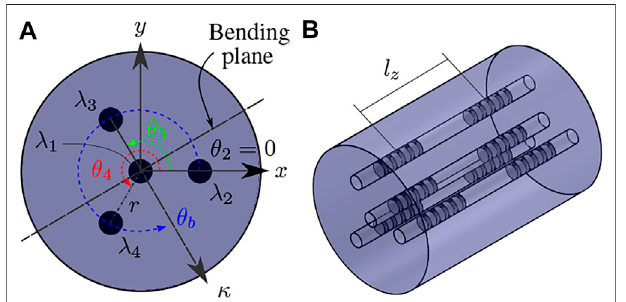
FIGURE 1 | (A) cross-sectional view of a four core MCF where λ i represents the wavelength in the i th core, r is the distance between the center of the i th core and the fi ber ’ s central axis, and θ b is the angle of the bending plane with respect to the x -axis which intersects the second core, (B) isometric view of a segment with four cores and two FBG sets, i.e. four FBGs at a given cross-section, separated by a center-to-center distance l z